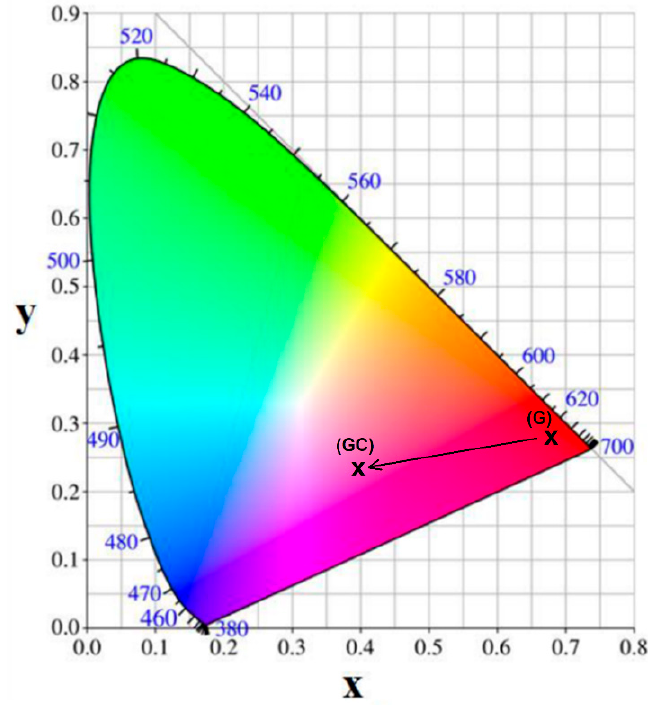
Figure 7. The chromaticity coordinates of the Commission Internationale de l’Eclairage (CIE) chromaticity diagram of the Eu-doped chloroborate glass (G) and glass-ceramic (GC) samples.